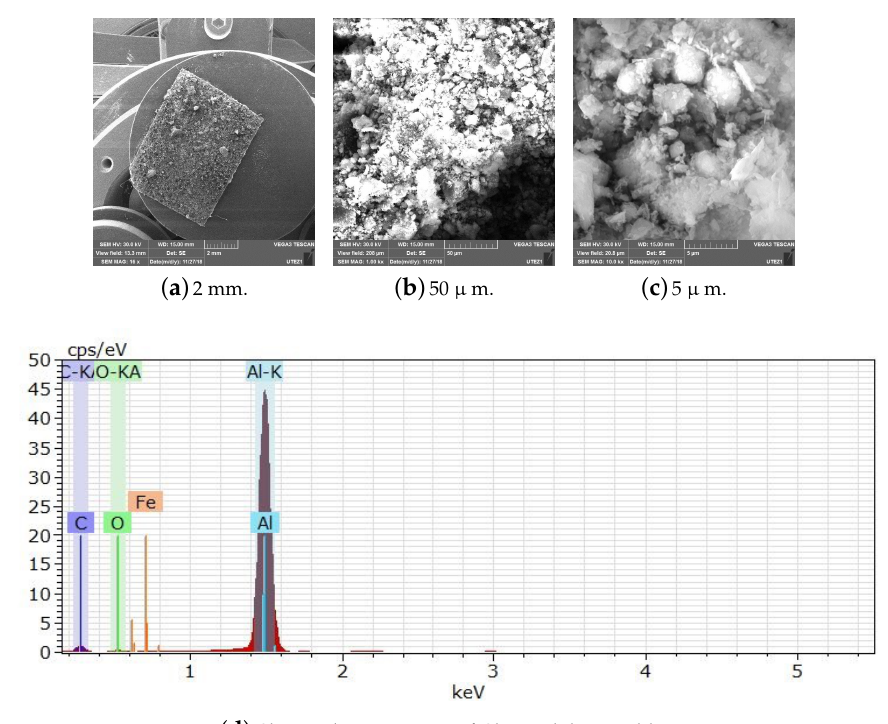
Figure A15. Scale display through SEM and chemical composition of